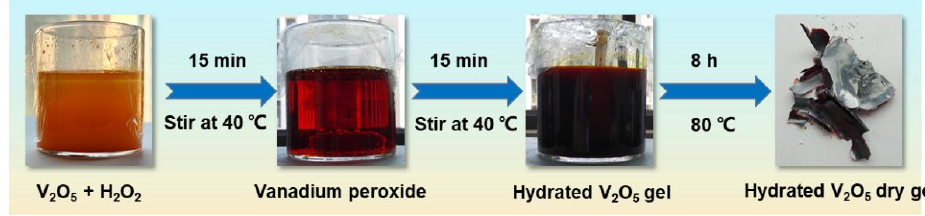
Figure 1. Schematic synthesis process of the V 2 O 5 dry gel. Table 1. Representative routes for the synthesis of hydrated V 2 O 5 materials in previous literature. Vanadium